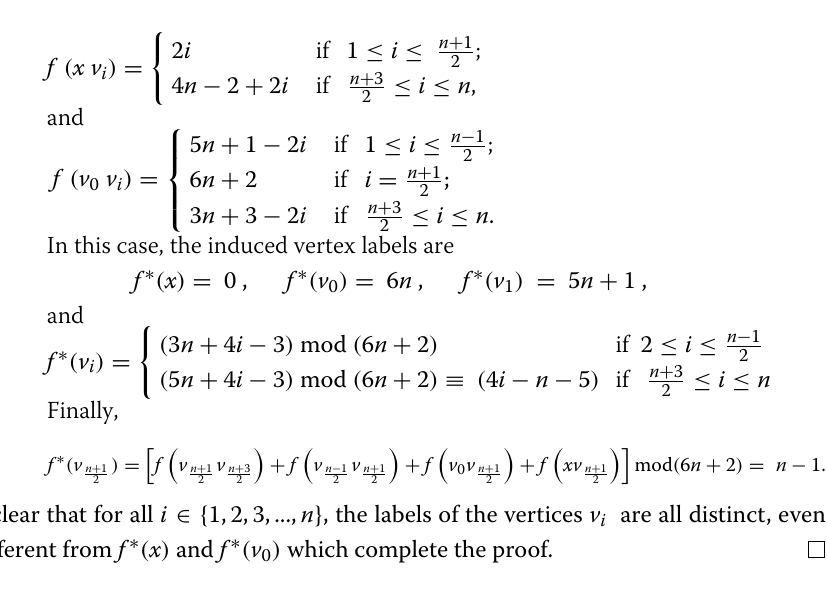
Illustration: In Fig. 3, we present an edge even graceful labeling of the graphs K 1 + W 8 and K 1 + W 10 . Illustration: In Fig. 4, we present an edge even graceful labeling of the graphs K 1 + W 9 , K 1 + W 11 , K 1 + W 5 and K 1 + W 7 .